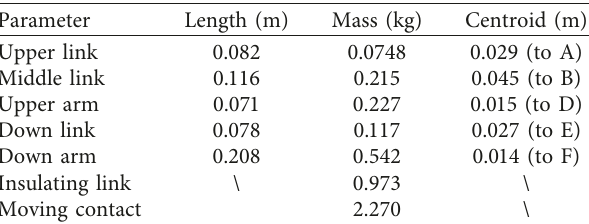
Figure 1: The schematic diagram of the operating mechanism. 1: upper link; 2: middle link; 3: upper arm; 4: down link; 5: down arm; 6: insulating link; 7: buffer spring; 8: moving contact; and 9: static Table 1: Inertia and geometric parameters of the mechanical system.